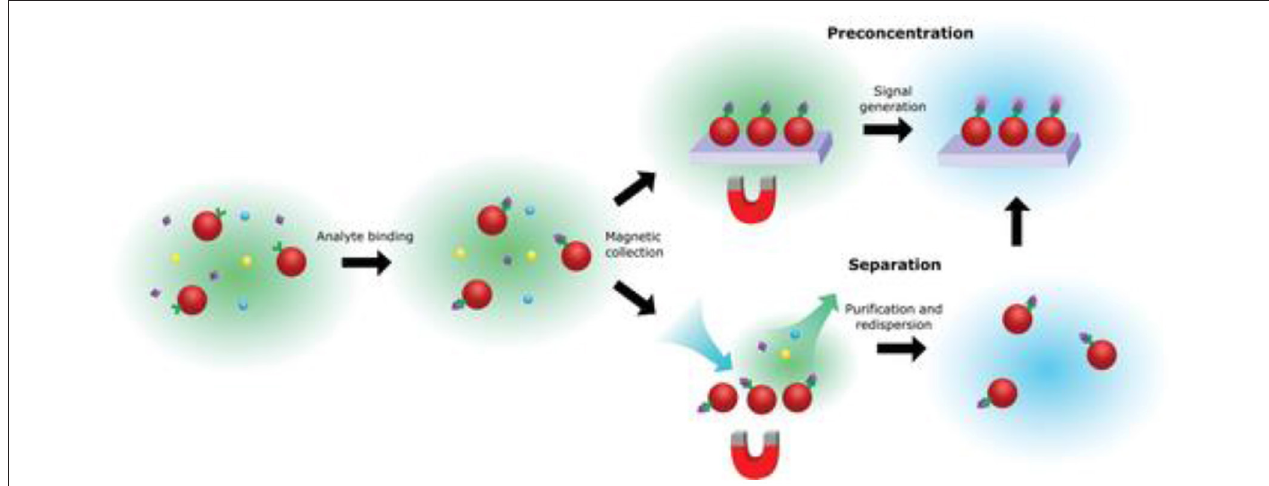
FIGURE 7 | Basic principles of magnetic enrichment. Being a “hero” in solving the mass transport issue for ultrasensitive biosensors, the use of magnetic nanoparticles can be used for pre-concentration and/or separation of the analyte, while at the same time reducing non-specific effects (Gloag et al., 2019). Copyright with permission from Wiley.